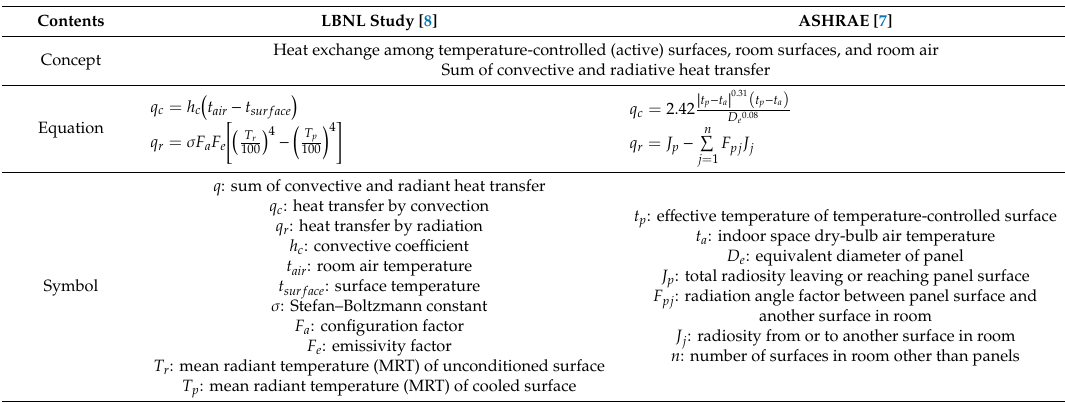
Table 2. Concept of cooling capacity of CRCP in the Lawrence Berkeley National Laboratory (LBNL) study and American Society of Heating, Refrigerating and Air-Conditioning Engineers (ASHRAE).